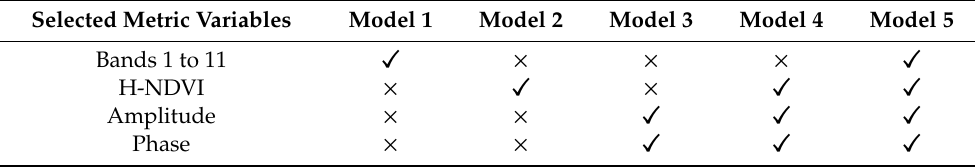
Table 1. Metric variable selection for each classification